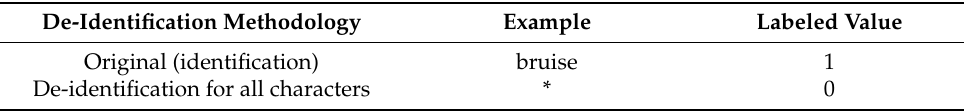
Table 4. Labeling rule for other items. An asterisk (*) indicates a de-identified character from personal